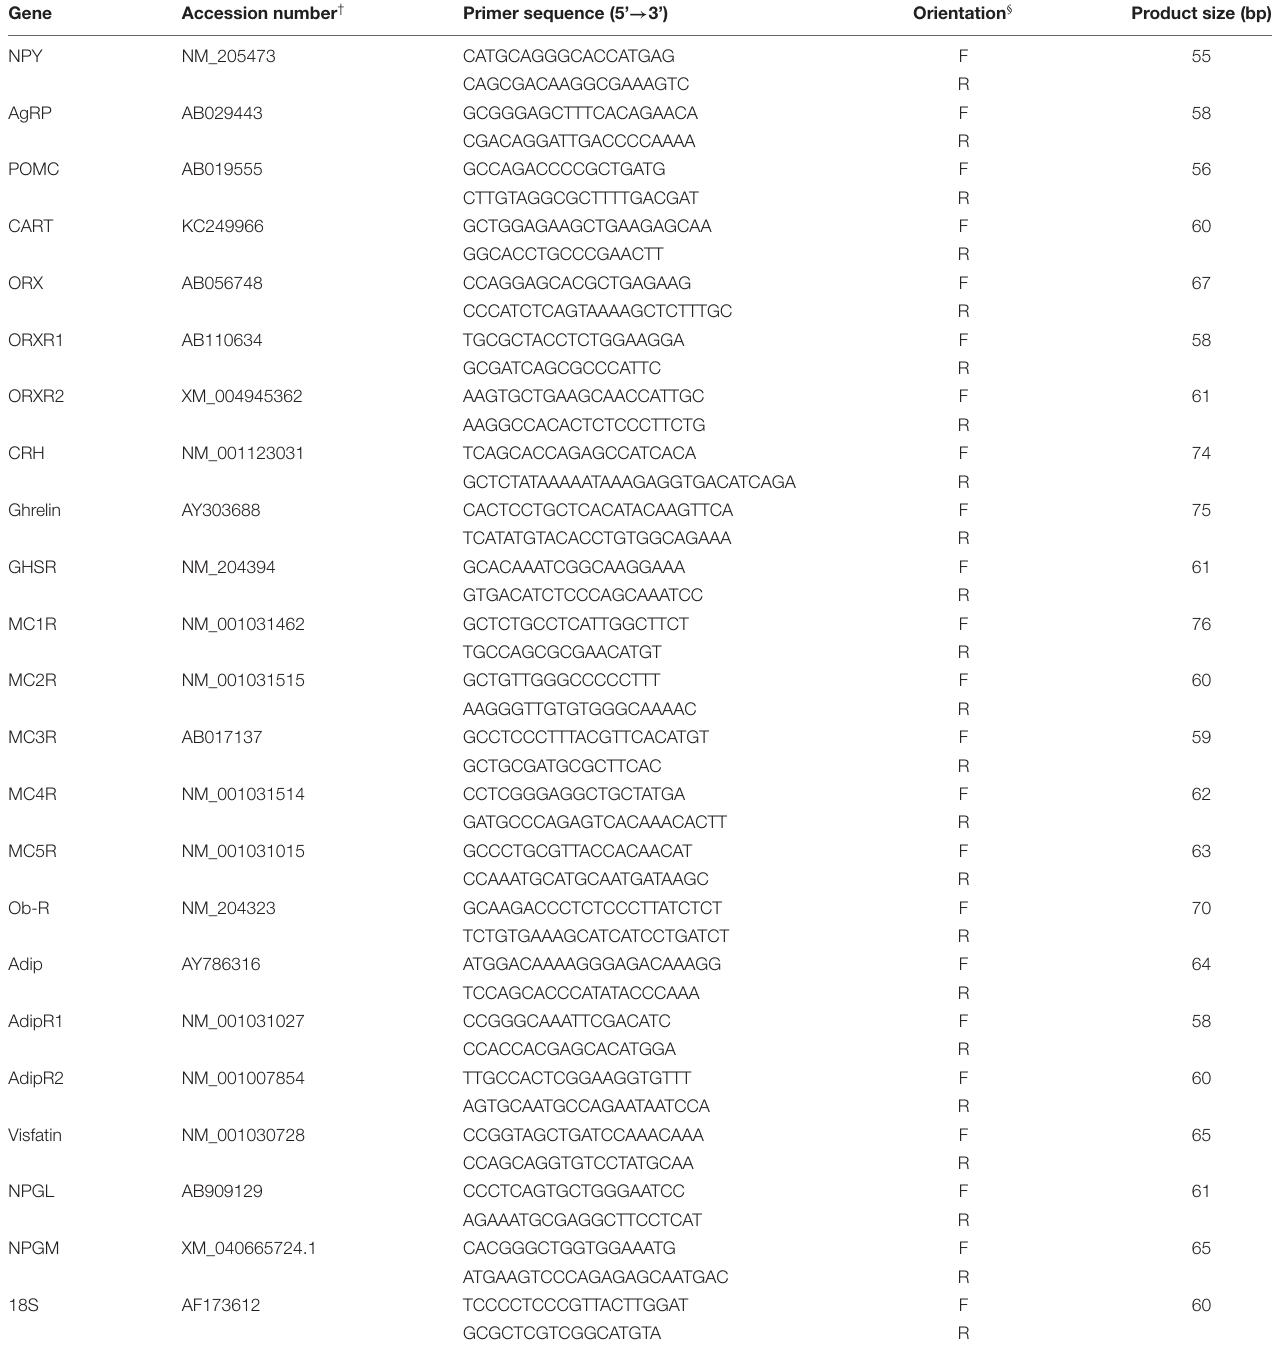
TABLE 2 | List of qPCR chicken-specific oligonucleotide